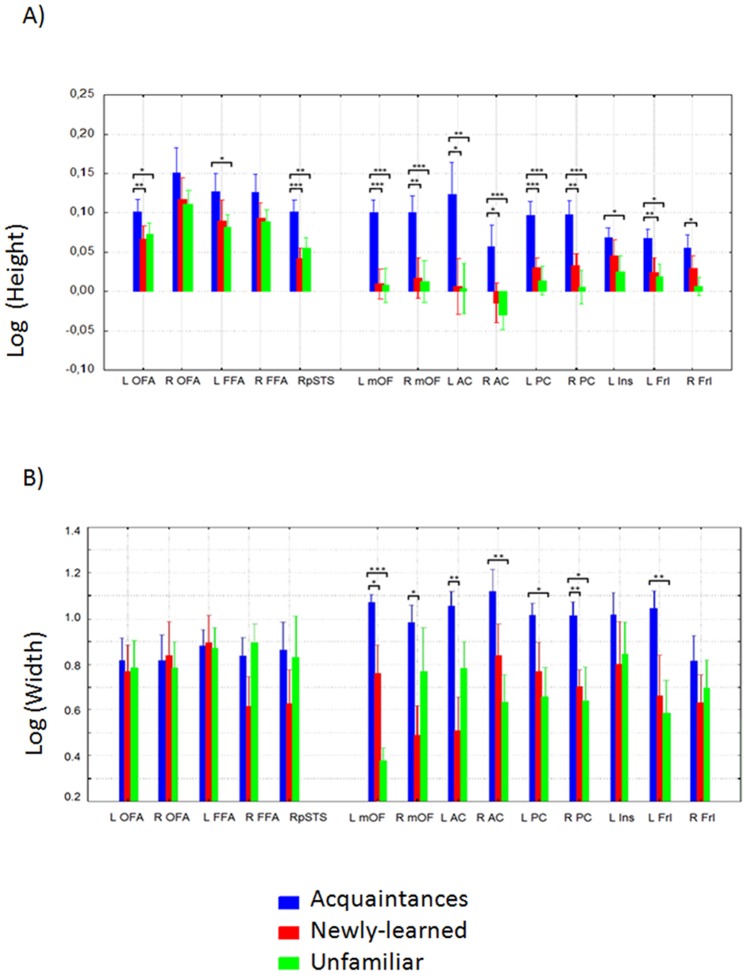
Bar graphs showing the parameters extracted from the estimated HRFs, for all face condition and all ROIs A) Height B) Width.Error bars correspond to the standard error. The results from the two-way interaction rm ANOVA between face condition and ROI are shown (significant differences between the conditions are indicated: * p<0.05, ** p<0.01, ***p<0.001).